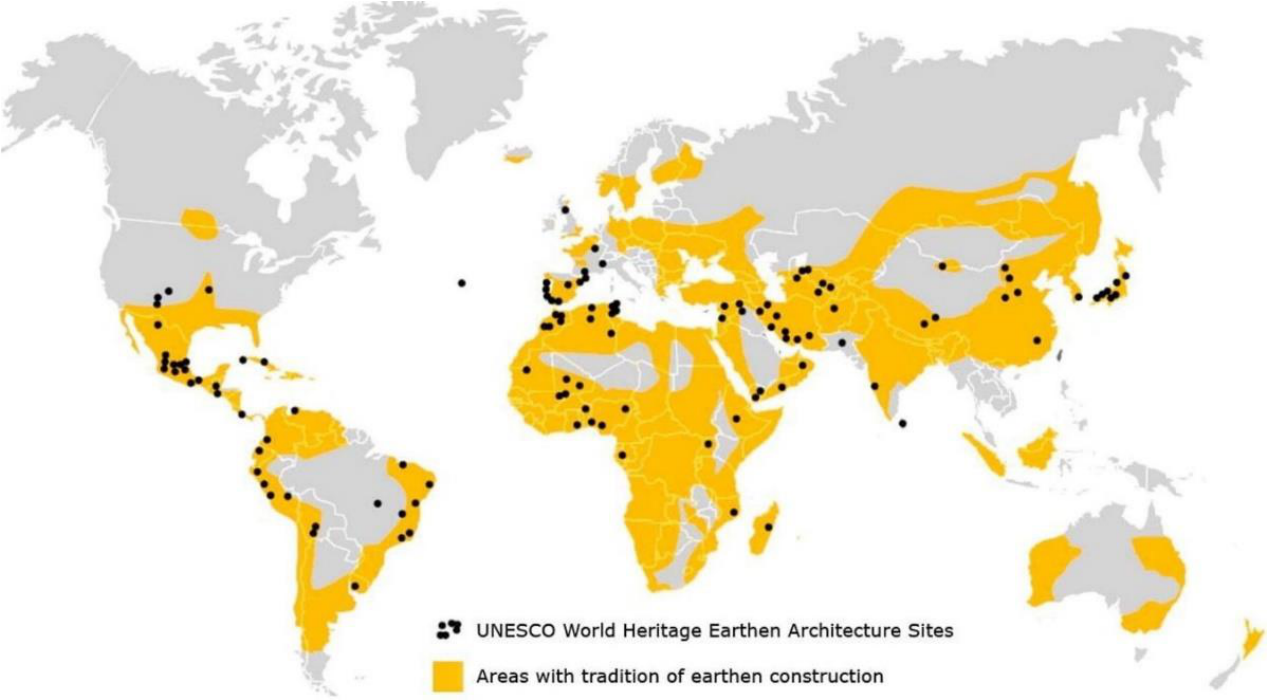
Figure 1. Earth construction regions in the world and UNESCO World Heritage Sites [7].